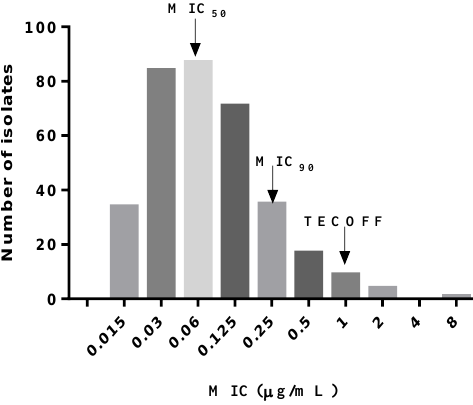
Figure 2. MIC distribution of cefquinome against 342 S. suis isolates. 2.2. MIC, MBC, MPC and PAE of Cefquinome against SS0061 The MIC values of cefquinome against SS0061 were both 0.125 µ g/mL in vitro and ex vivo, and the minimum bactericidal concentration (MBC) values were 0.125 and 0.25 µ g/mL in vitro and ex vivo, respectively. The mutant prevention concentration (MPC) value of cefquinome against SS0061 was 0.4 µ g/mL, and the mutant selection window (MSW) was 0.125–0.4 µ g/mL, indicating that the resistant mutant selection window was narrow. Post-antibiotic effect (PAE) of different concentrations of cefquinome (1 × , 2 × , or 4 × MIC) and exposure time (1 or 2 h) are shown in Table 2. With an increase in drug concentrations and exposure time, the PAEs are enhanced. Table 2. Post-antibiotic effect (PAE) after 1 and 2 h on SS0061. Concentrations